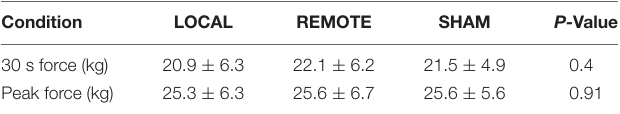
Condition LOCAL REMOTE SHAM P-